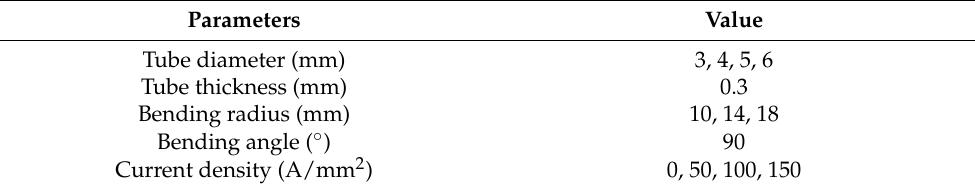
Figure 1. The three-dimensional (3D) finite-elements (FE) model of electrically-assisted rotary-draw bending (EA RDB) process of micro-tube. Table 2. Parameters used for the simulation of EA RDB process.